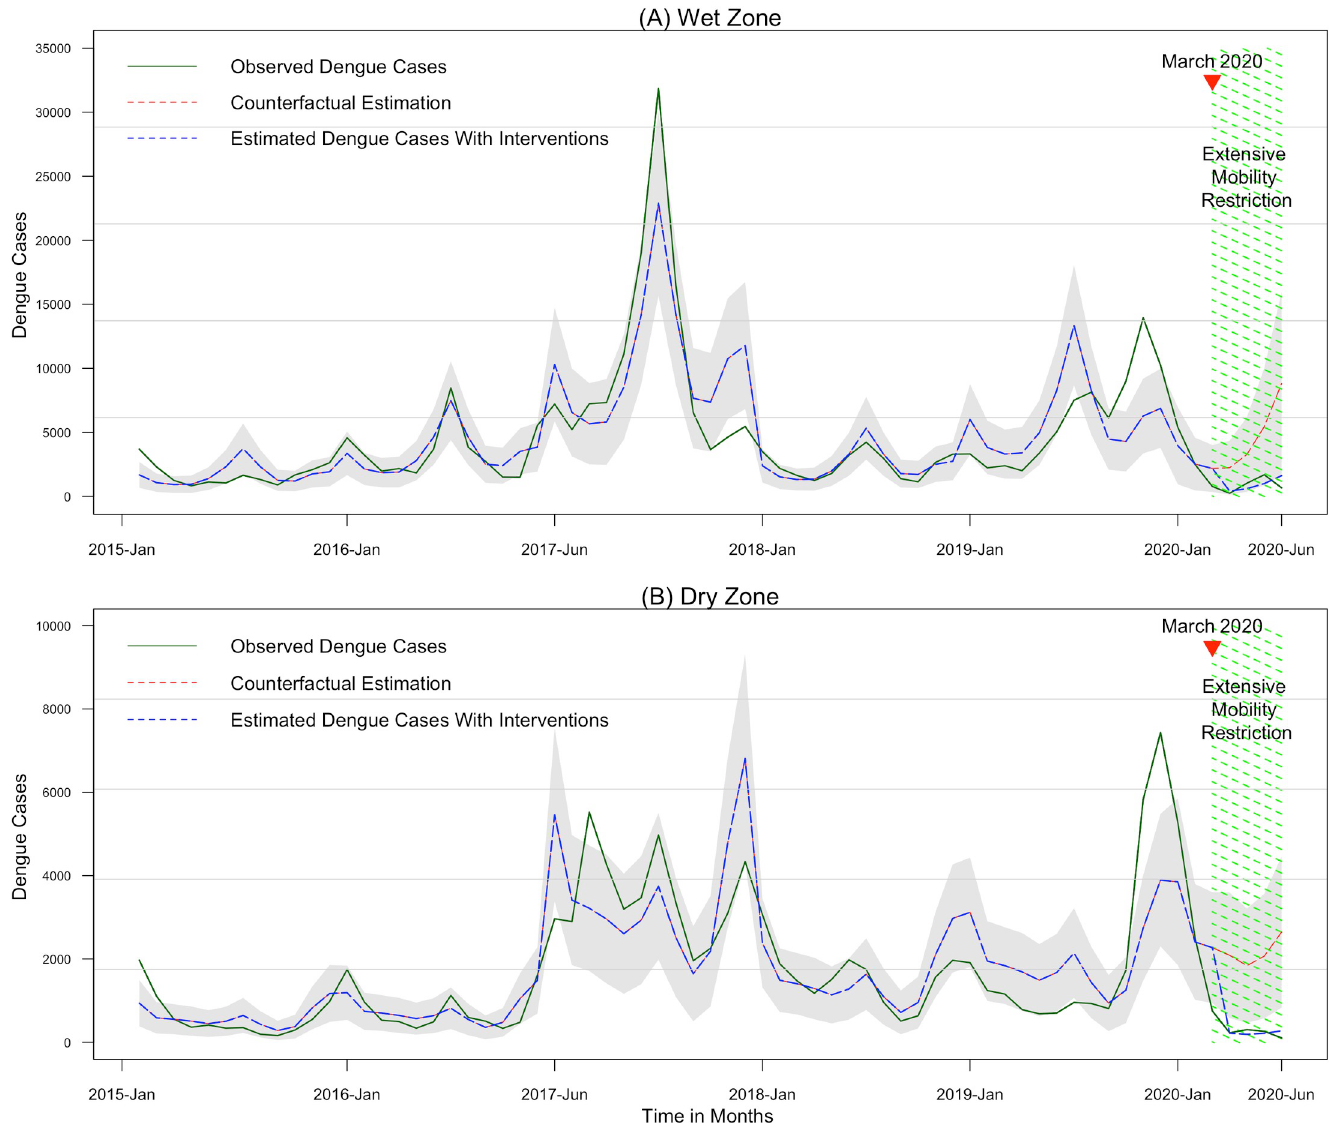
Fig 4. Time series plot of observed and estimated dengue cases from 2015 to 2020 July in wet and dry zones in Sri Lanka. (A) Wet zone. (B) Dry zone. The green line represents observed dengue cases. Blue dashed line represents the model predicted or estimated dengue cases with the lockdown intervention in place. The red dashed line represents estimated dengue cases without intervention or the counterfactual estimation. The grey zone indicates the lower and upper limits of the 95% confidence intervals for estimated dengue cases at each month.